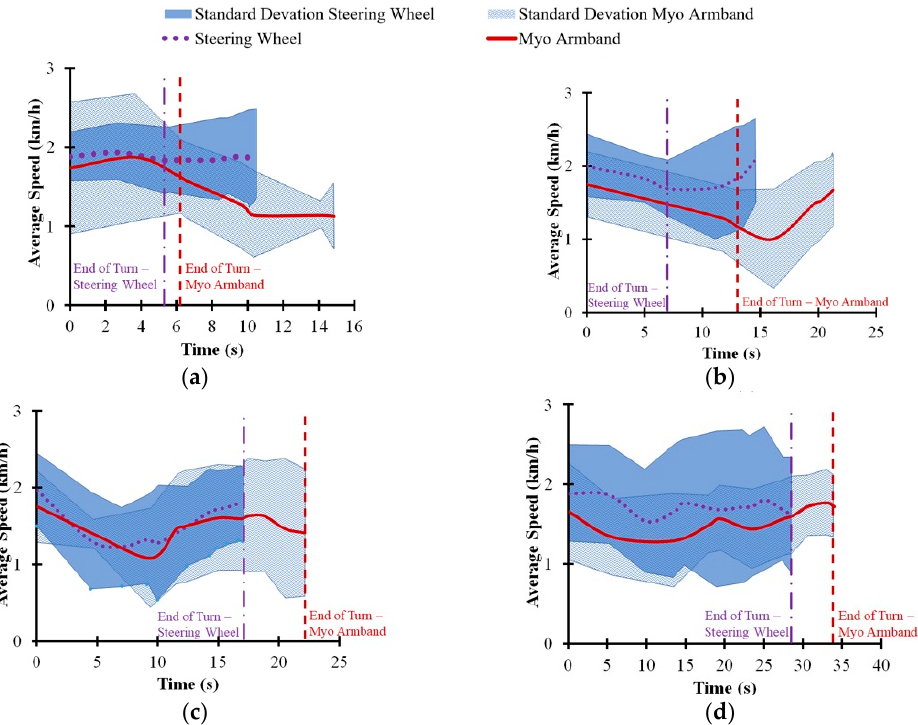
Figure 9. Average vehicle speed associated with steering wheel and Myo armband for ( a ) 45° turn, ( b ) 90° turn, ( c ) narrow U-turn, and ( d ) wide U-turn. Vertical dashed lines indicate average times when drivers exited turns.